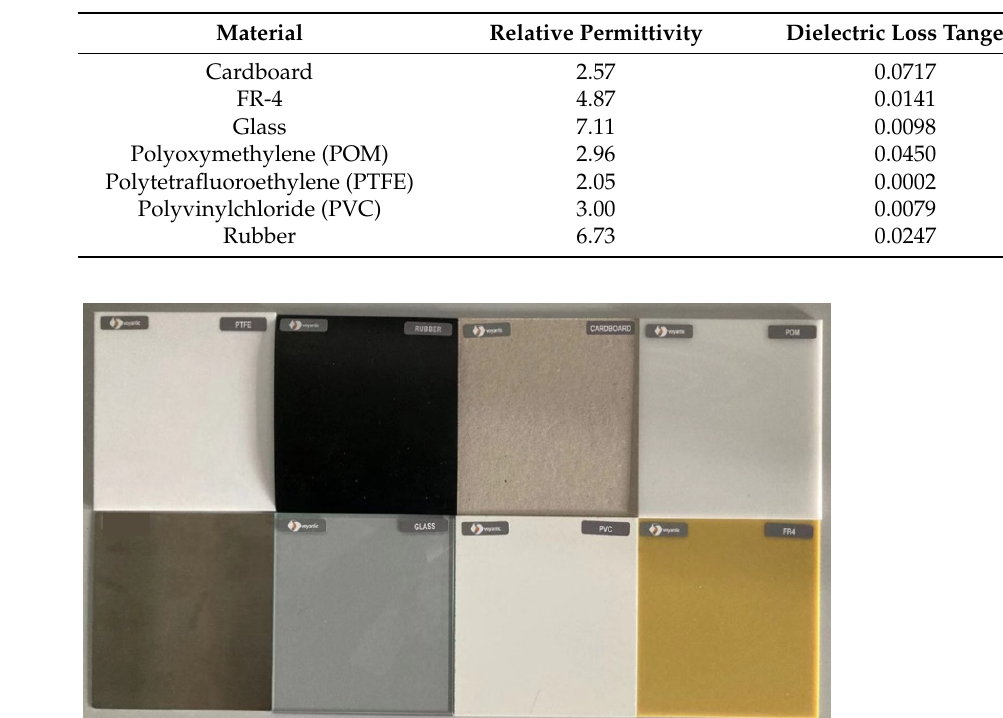
Figure 2. MLNN structure for RFID-based sensing: ( a ) material identification MLNN and ( b ) crack sensing MLNN.